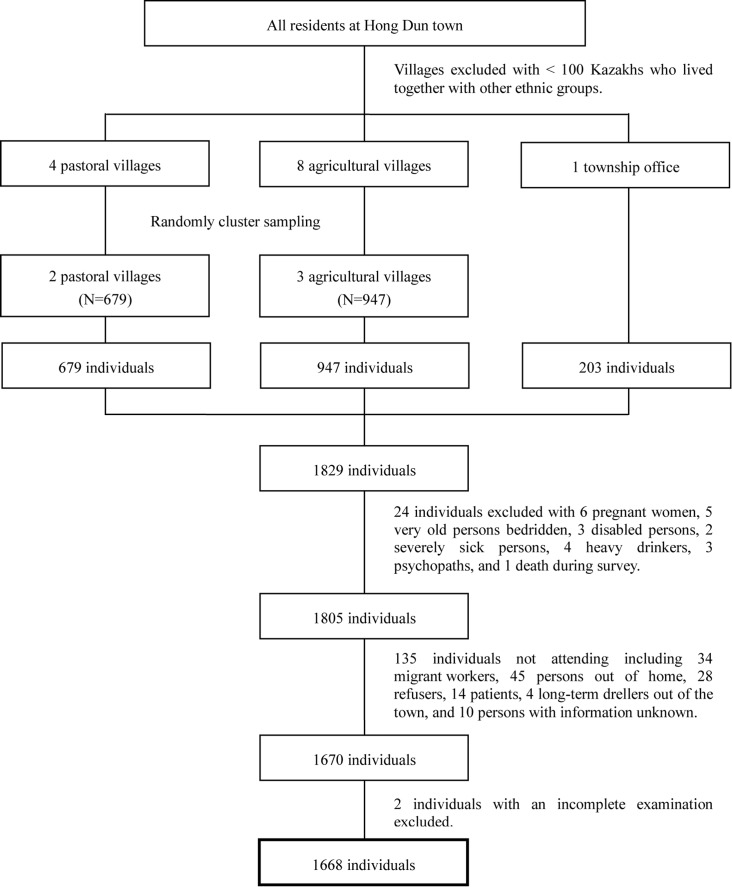
Flow chart for recruitment of participants.